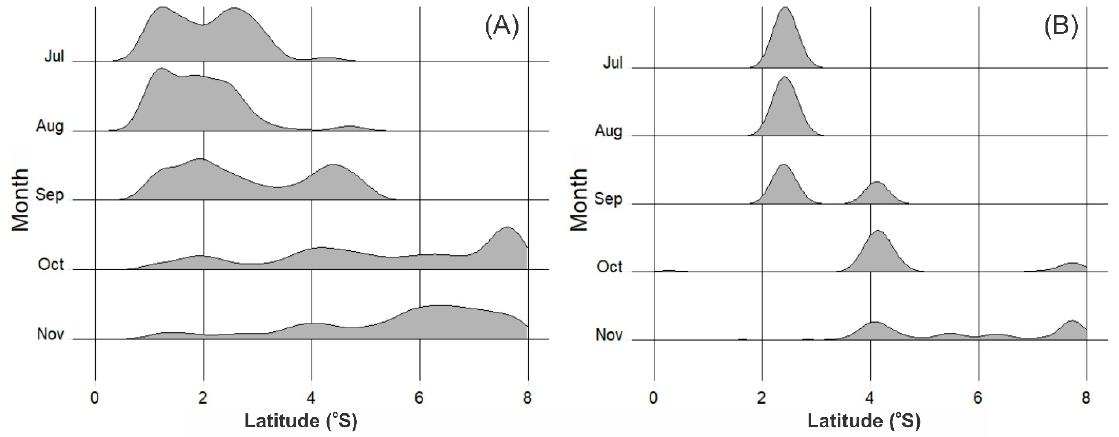
Figure 11. Spatial and temporal movement of estimated SHI ≥ 0.75 from the model ( A ) and the density of observed skipjack fishery data ( B